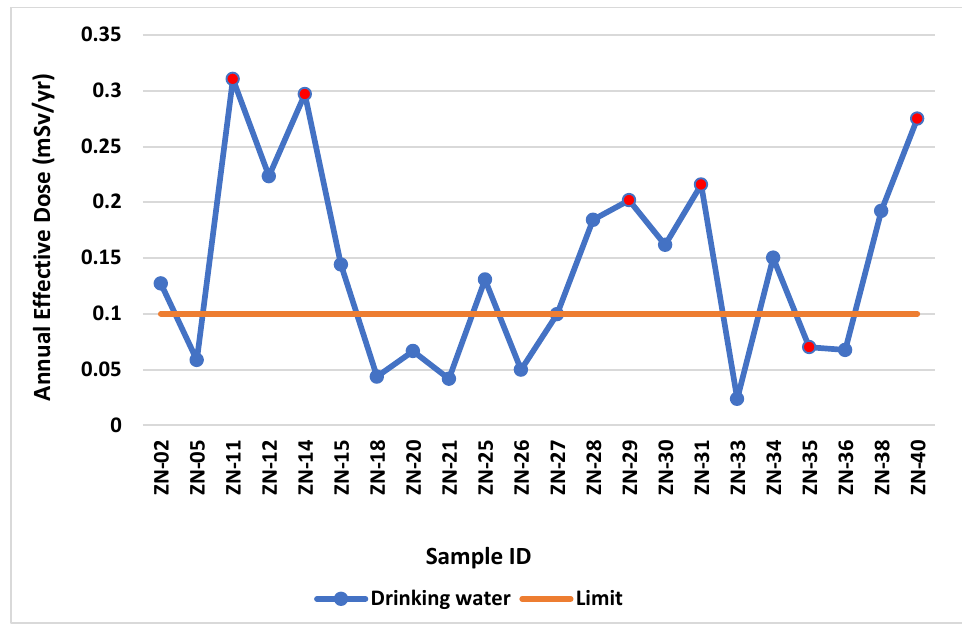
Figure 8. 238 U- related Annual Effective Dose (AED) and associated regulatory limit for drinking water. Red points represent groundwater samples.